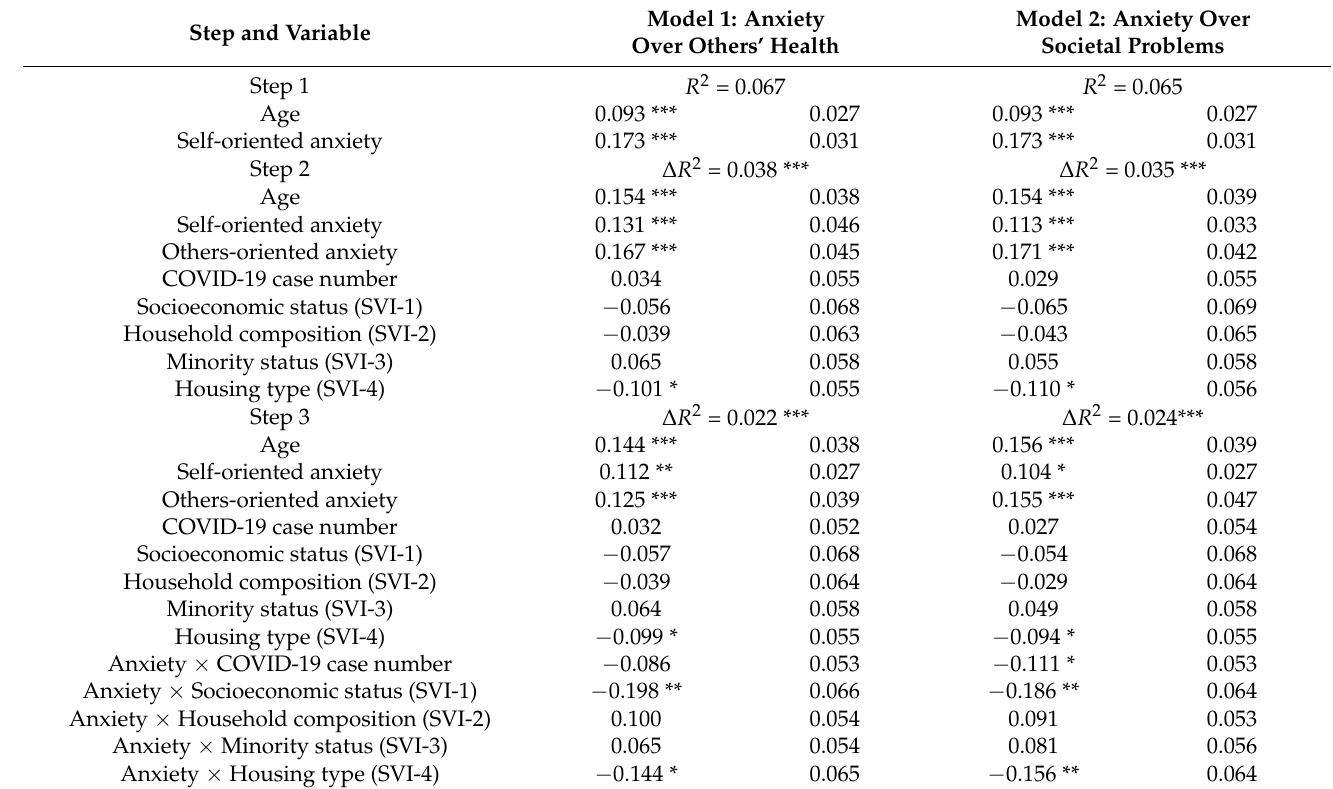
Table 1. Community risk factors as moderators in the association between two forms of pandemic- specific anxiety and physical distancing